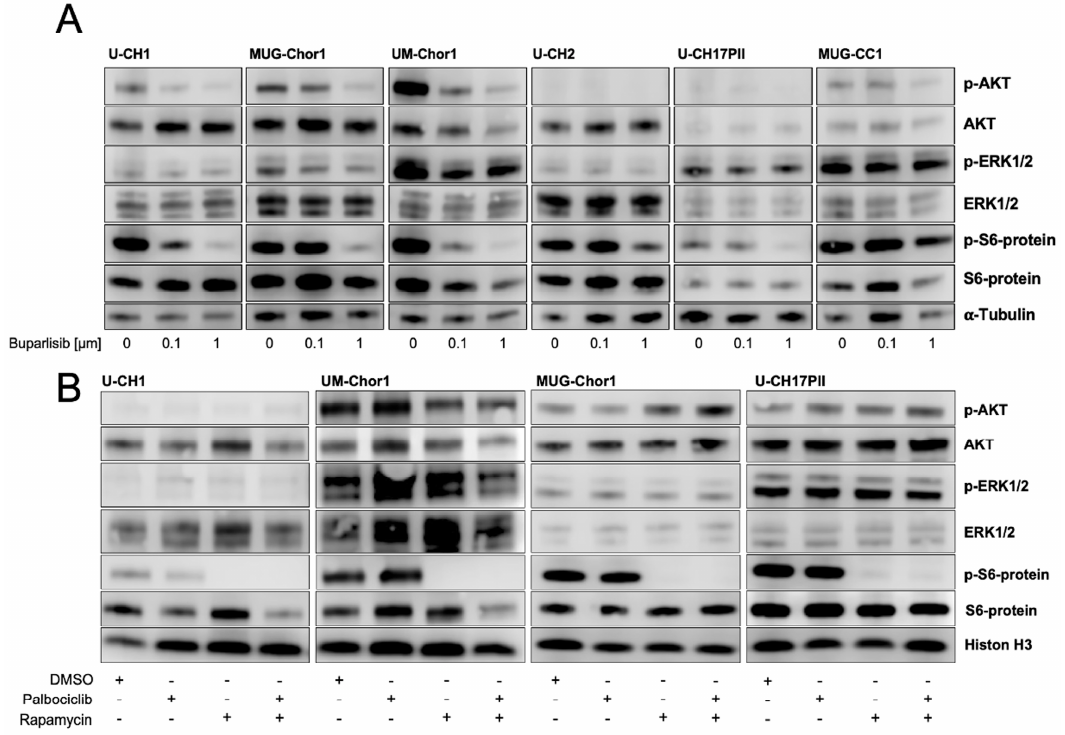
Figure 4. Western blot analysis of selected components of the PI3K/AKT/mTOR pathway. ( A ) A dose-dependent reduction in the phospho-S6 protein was observed in six chordoma cell lines following a 6 h treatment with buparlisib (0.1 µM and 1 µM). Reduced phospho-AKT levels were seen in U-CH1, MUG-Chor1, UM-Chor1, and MUG-CC1. ( B ) In all four of the chordoma cell lines tested, treatment with rapamycin (1 µM) alone and in combination with palbociclib (0.5 µM) induced a clear reduction in the phospho-S6 protein. No significant effect on phosoho-S6 protein levels was observed following a 6 h incubation with palbociclib alone. The uncropped blots are shown in the Supplementary Materials.